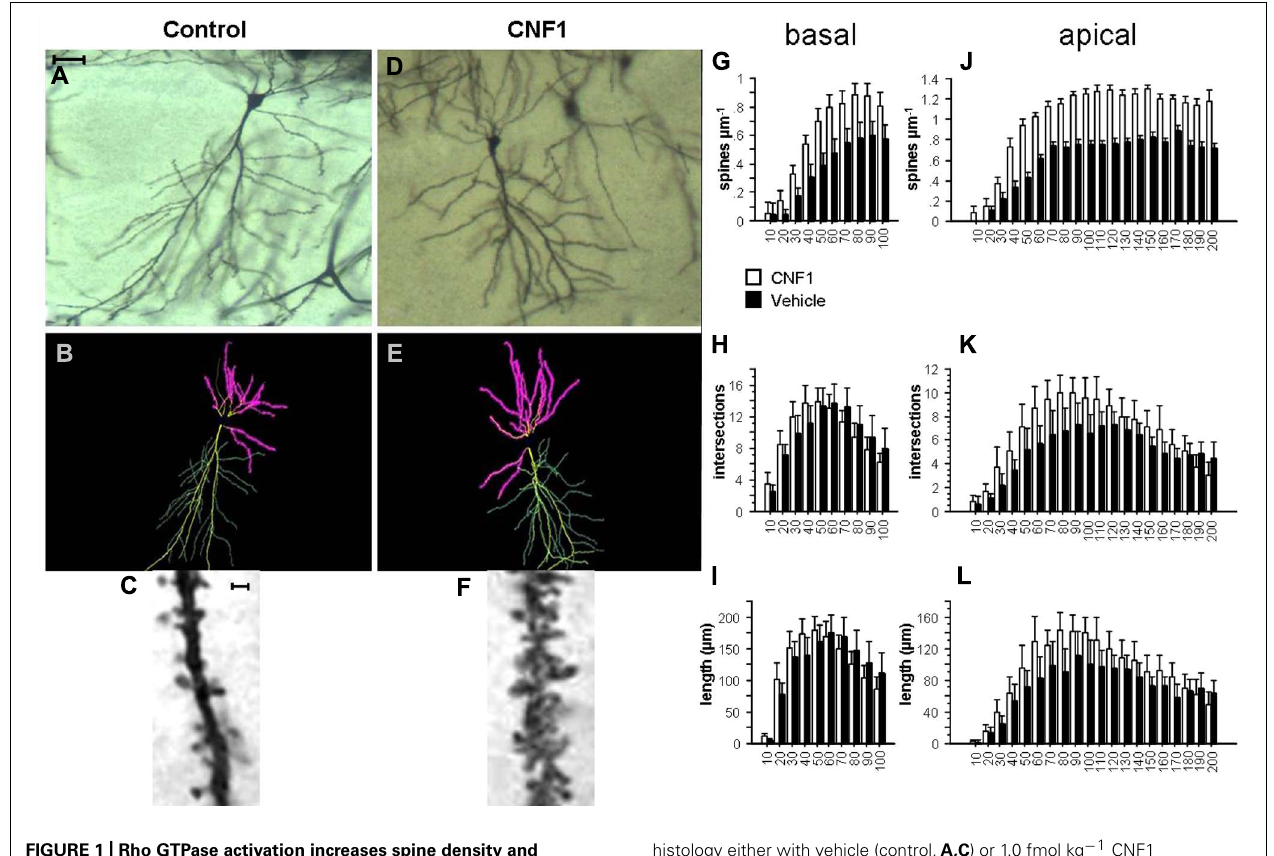
histology either with vehicle (control, A,C ) or 1.0 fmol kg − 1 CNF1 i.c.v. (D,F) . Spine density (G,J) , number of intersections (H,K) , and average dendrite length (I,L) in basal (G,I) and apical (J,L) dendrites are plotted by distance from cell soma ( μ m). Mean ± SEM; n = 16 in each